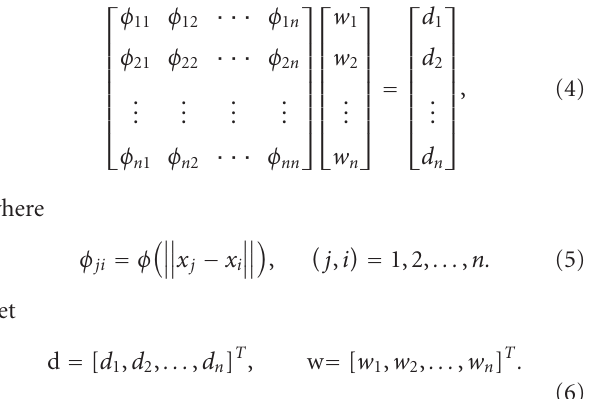
Table 1: End milling parameters used in the study. Parameter Meaning S m Spindle speed (rpm) F m Feed rate (ipm) D m Depth of cut (in) R m Roughness (